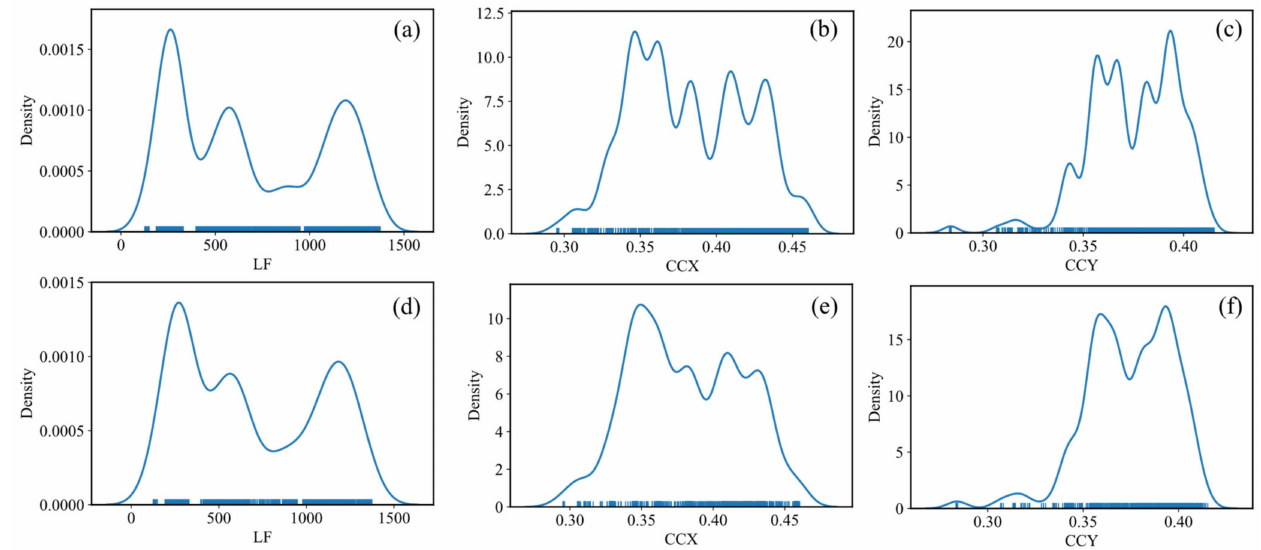
Figure 4. Density distribution of ( a ) LF, ( b ) CCX, and ( c ) CCY in training dataset. Density distribution of ( d ) LF, ( e ) CCX, and ( f ) CCY in test